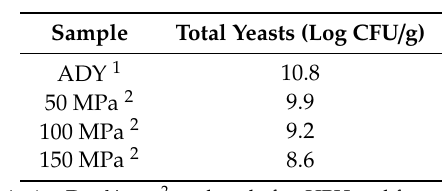
Table 2. Application of HPH (50–150 MPa) to a water suspension of S. bayanus active dry yeast